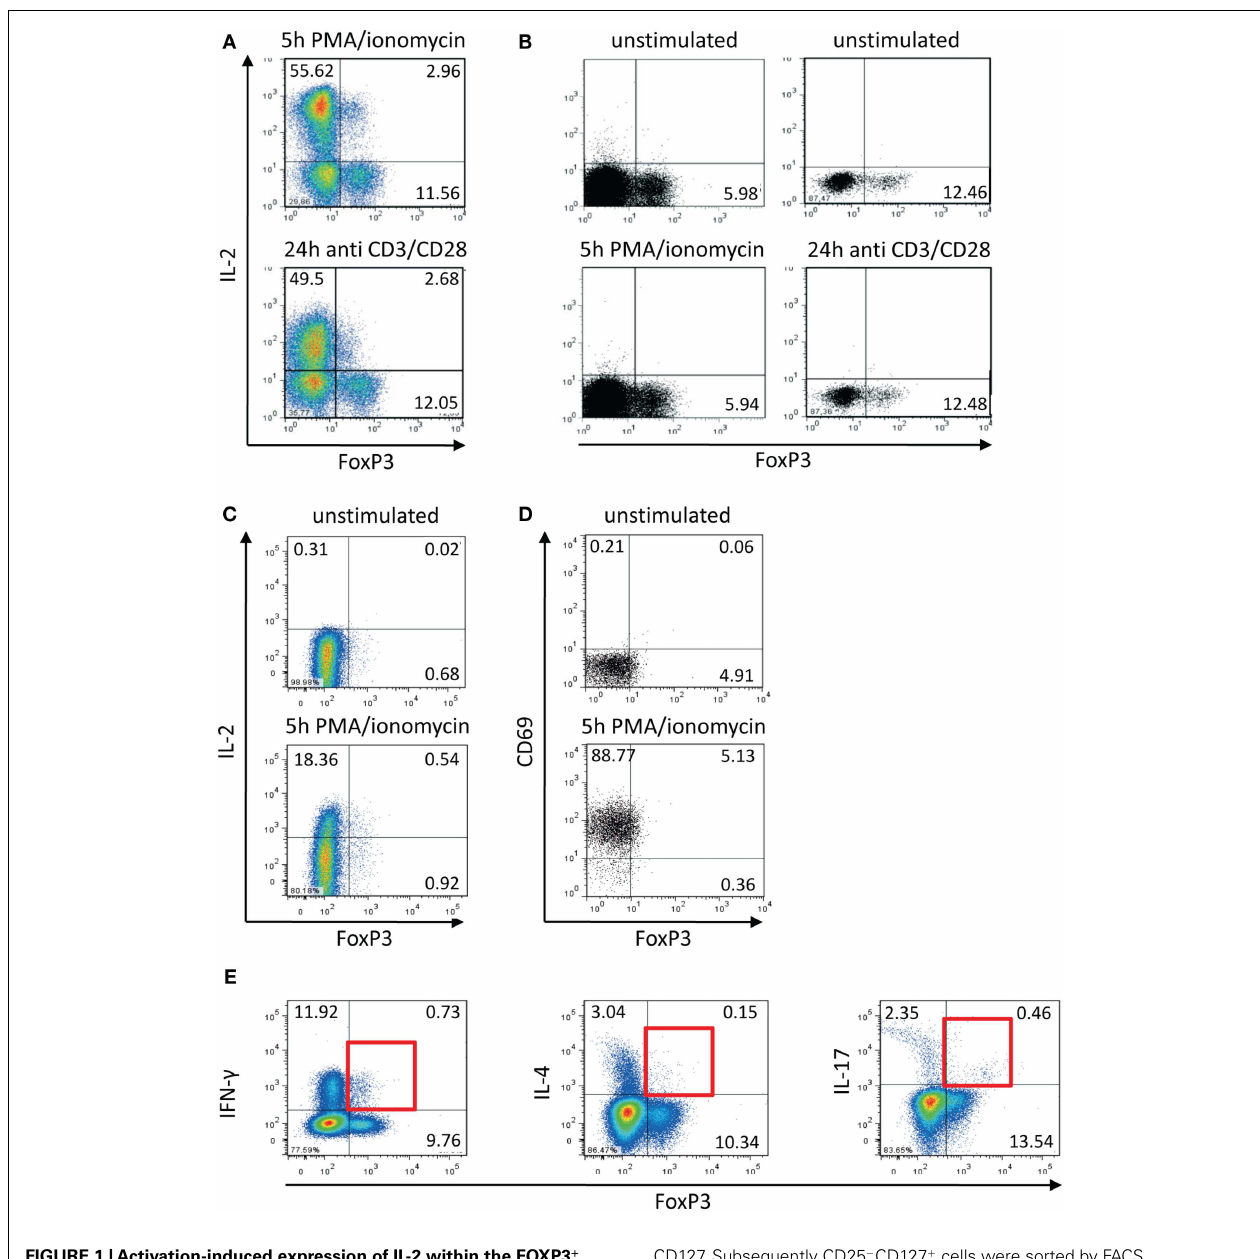
FIGURE 1 |Activation-induced expression of IL-2 within the FOXP3 + memoryT cell population. Human CD4 + CD45RO + T cells were isolated using magnetic cell-sorting. (A,B) Cells were stimulated with PMA/ionomycin and antibodies against CD3/CD28 for 5 and 24h, respectively, and subsequently stained with fluorophore-coupled antibodies and analyzed by flow cytometry. (C) CD4 + CD45RO + T cells were stained with fluorophore-coupled antibodies against CD25 and